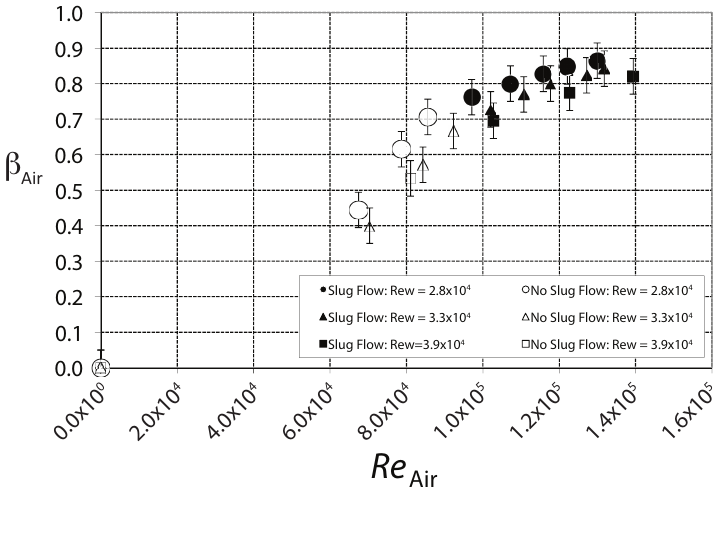
Figure 10. (cid:12) vs. air inlet and water inlet Reynold’s numbers. Air